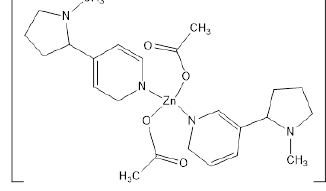
Figure 2. Structure of zinc-nicotine